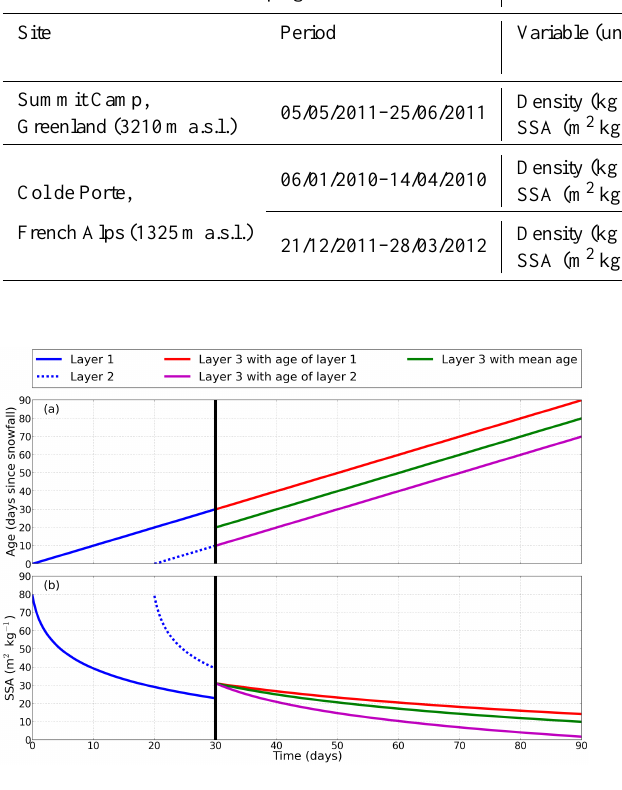
Fig. 2: Time evolution of layer age (a) and SSA (b) in a multi-layer model, simulated using the parametrization T07 (Taillandier et al., 2007). Layer 1 and layer 2 are created at different times to take into account new snowfalls. At t = 30 days, these two layers aggregate and give rise to layer 3. The age of the new-formed layer has to be chosen arbitrarily and this has an impact on the SSA rate of change.